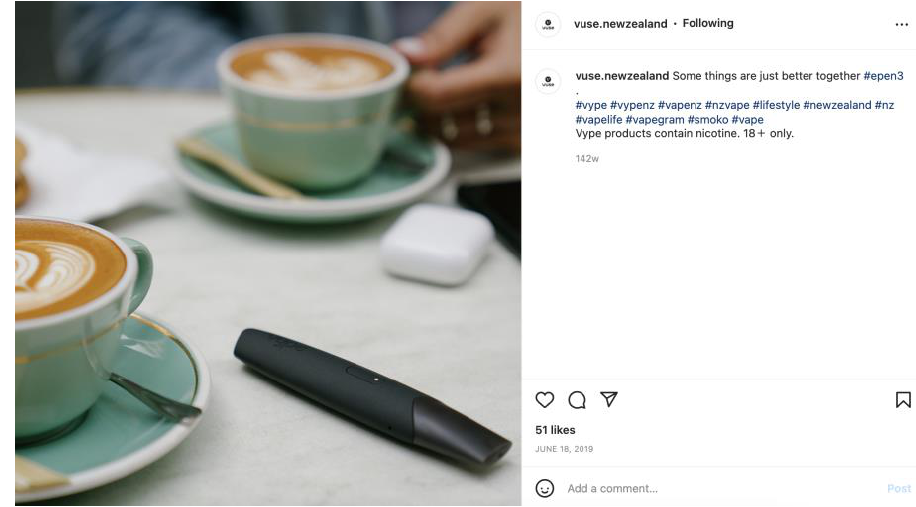
Figure 6. Example of an Instagram post positioning e-cigarettes with everyday items.